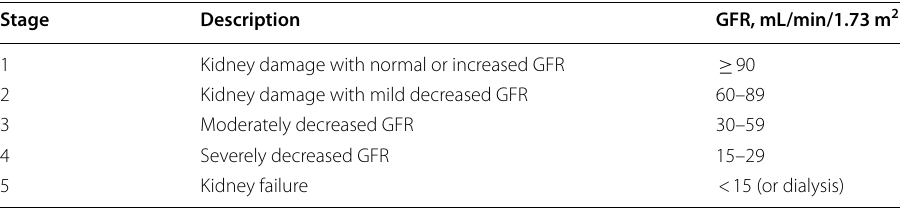
Table 2 Classification of CKD by GFR (International Society of Nephrology2013; National Kidney Foundation, Inc